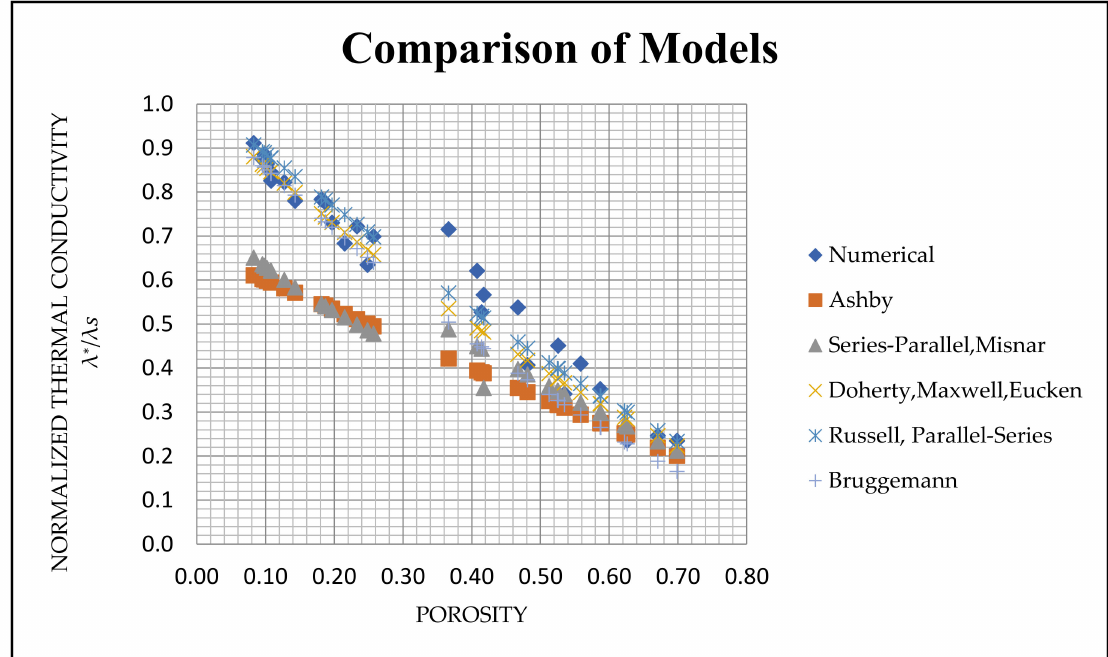
Figure 11. Normalised thermal conductivity predictions of the theoretical models from Table 3, as a function of the foam porosity in comparison with the numerical results ( λ s = 225.3 W/ ( m · K ))